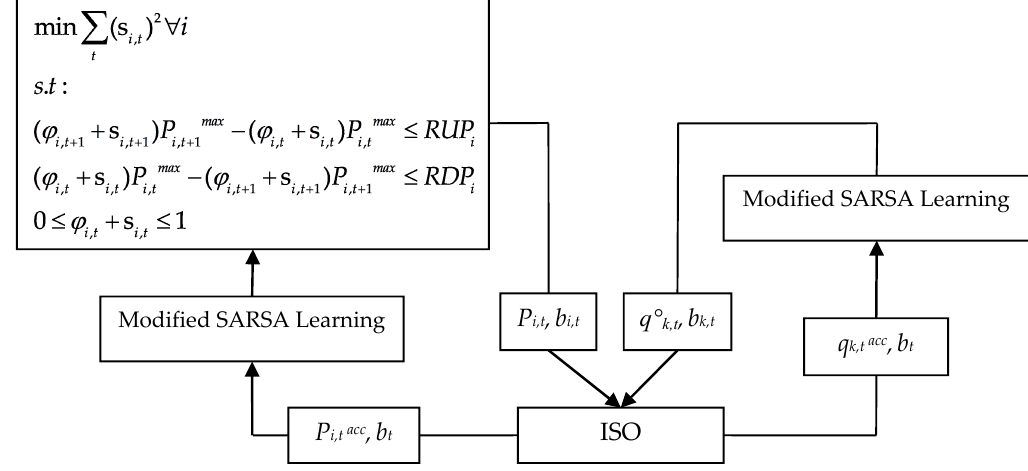
Figure 1. Market coordination mechanism and offering and bidding process of Gencos and Discos.